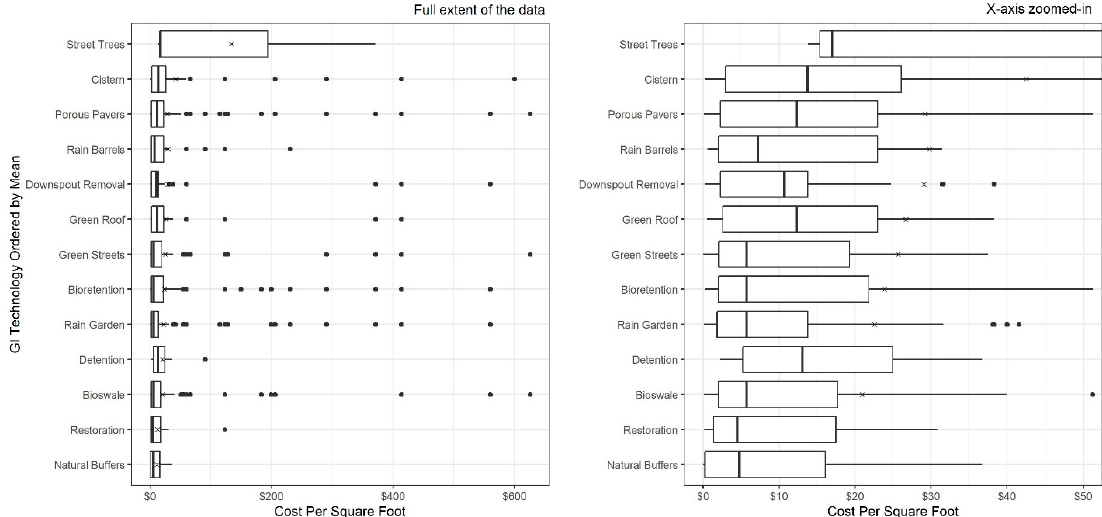
Figure 2. Cost per square foot for different GI technologies. Note: The figure on the left represents the full dataset, including all of the outliers, while the figure on the right limits the x -axis to show the majority of the cases. The boxes represent the interquartile range (IQR), the bars within the boxes represent the median, the points marked with an “ × ” represent the mean, and the dots are the outliers defined as 1.5 times the IQR in either direction.